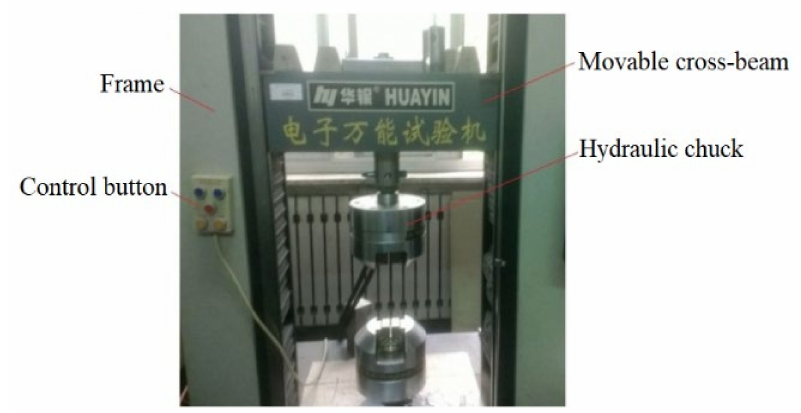
Figure 13. Electronic universal testing machine.